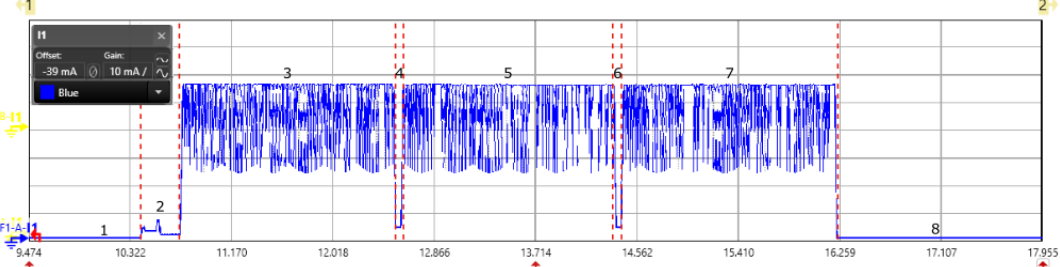
Figure 17. Scope view of a Sigfox data transmission captured using power analyzer for the measurement of energy